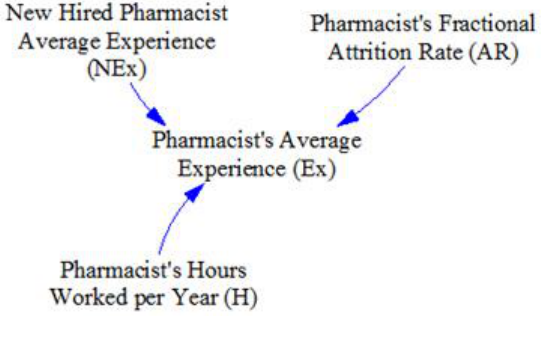
Figure 4. The Experience model for